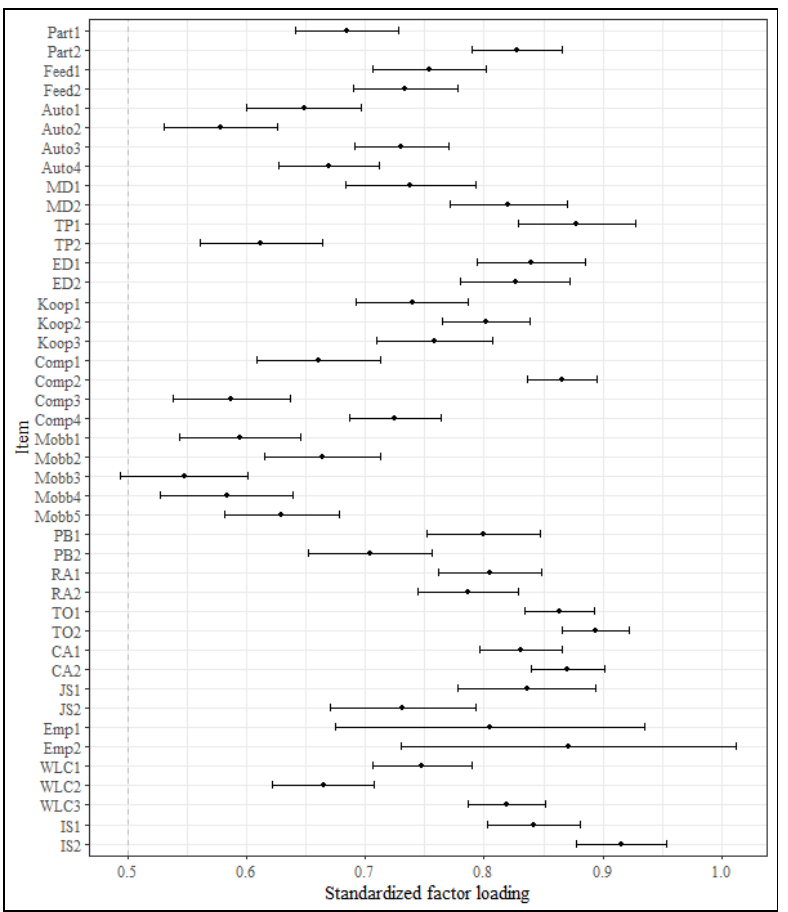
Figure 1. Standardized factor loadings with 95% confidence intervals for the total sample. Each item is specified to only load on its respective factor.